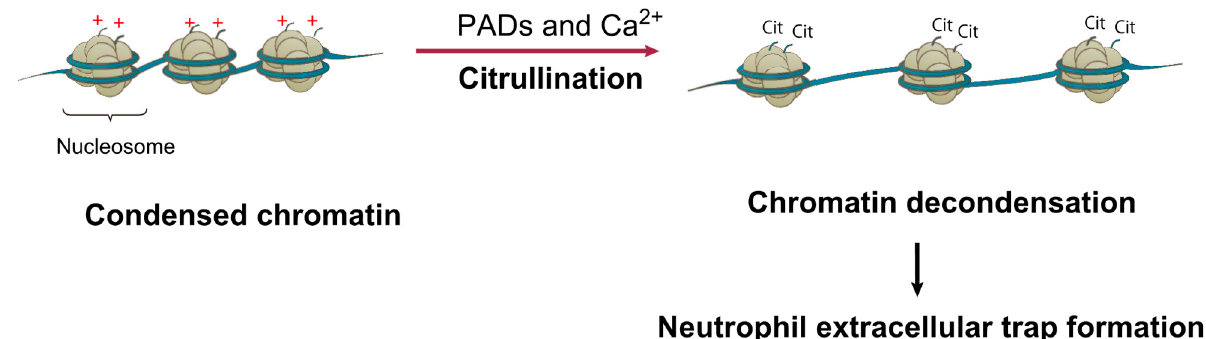
Figure 3. Citrullination of histone tails via peptidylarginine deiminase (PAD) leads to chromatin decondensation. PAD- mediated histone tail citrullination of positively charged arginine leads to generation of uncharged citrullines and, subse- quently, chromatin decondensation. Wang et al. proposed that histone hypercitrullination mediates chromatin deconden- sation and neutrophil extracellular trap formation (ref. [106]).